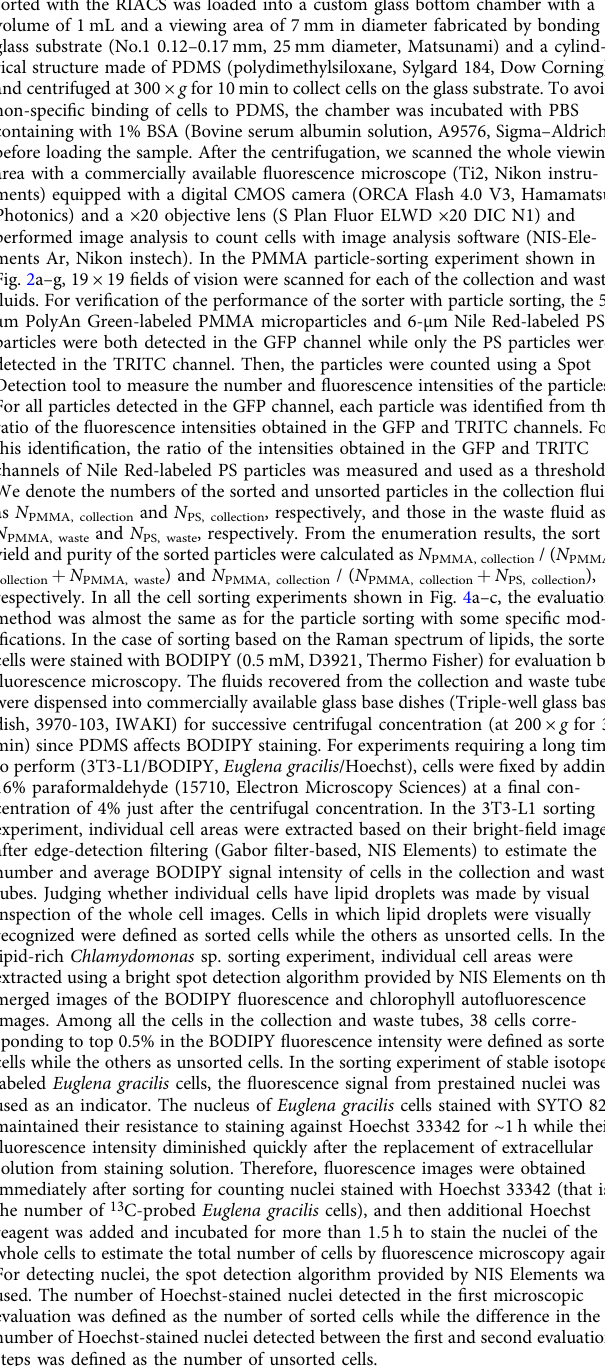
Fig. 6a, the difference between the two distributions in the 2D scatter plot of hiPSCs in carbohydrate and protein densities was identi fi ed, indicating